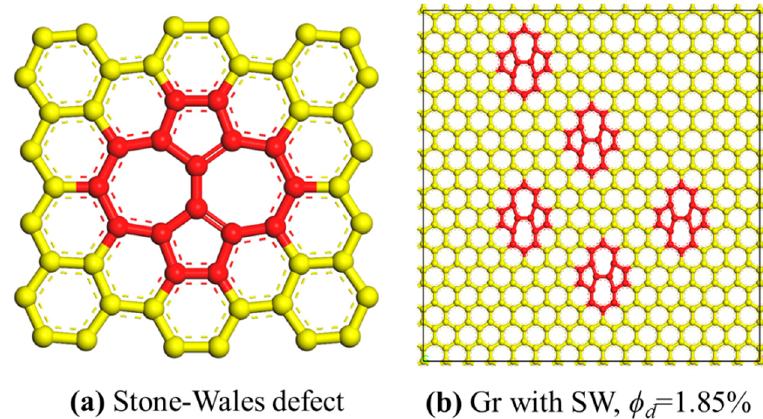
Figure 6. The molecular model of ( a ) Stone-Wales defect; ( b ) Gr sheet with SW, ϕ d = 1.85%.